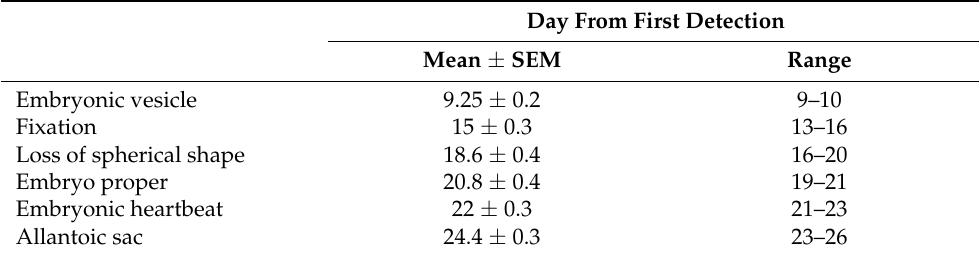
Table 1. Days from first ultrasonic detection of the EV developmental characteristics thereafter in eight